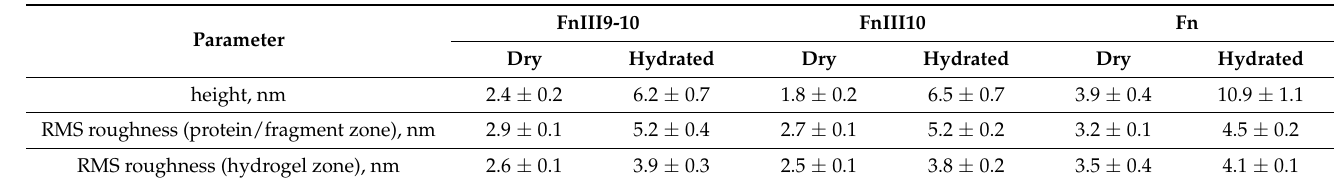
Table 1. Comparison of atomic force microscopy topographic data for FnIII9-10, FnIII10 and Fn layers formed on ultrathin PEG methacrylate coatings on silica (represented as mean and standard error values).